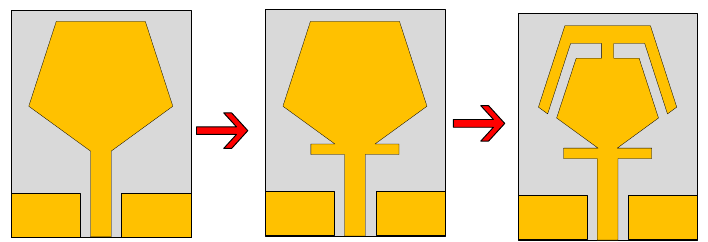
Figure 2. The design evolution of the proposed antenna.